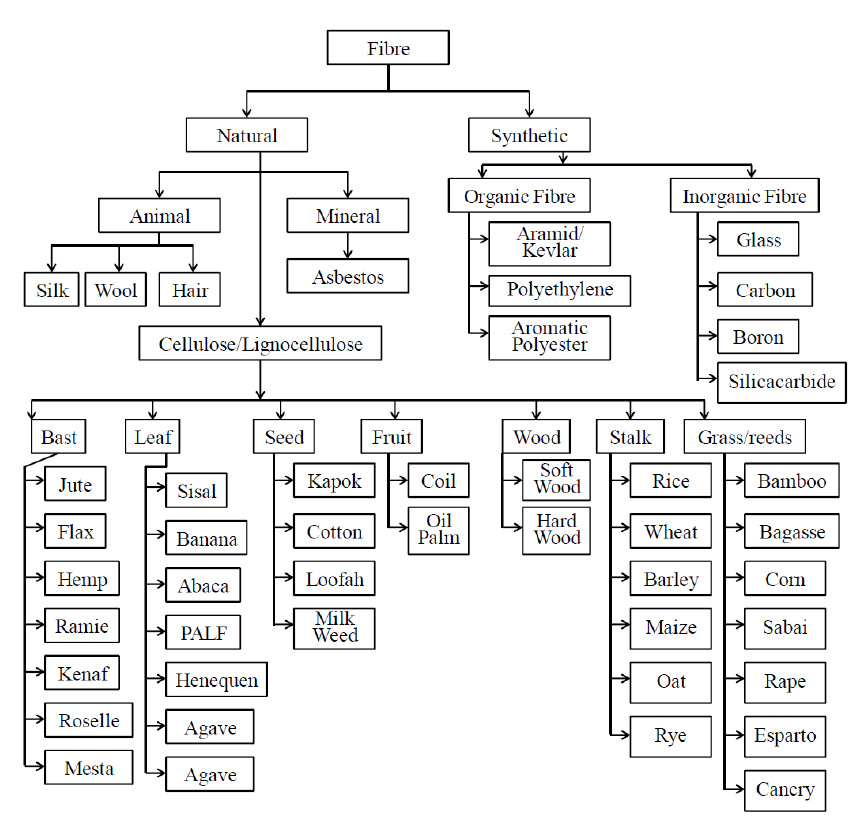
Figure 1. The classification of reinforcement fiber [22].